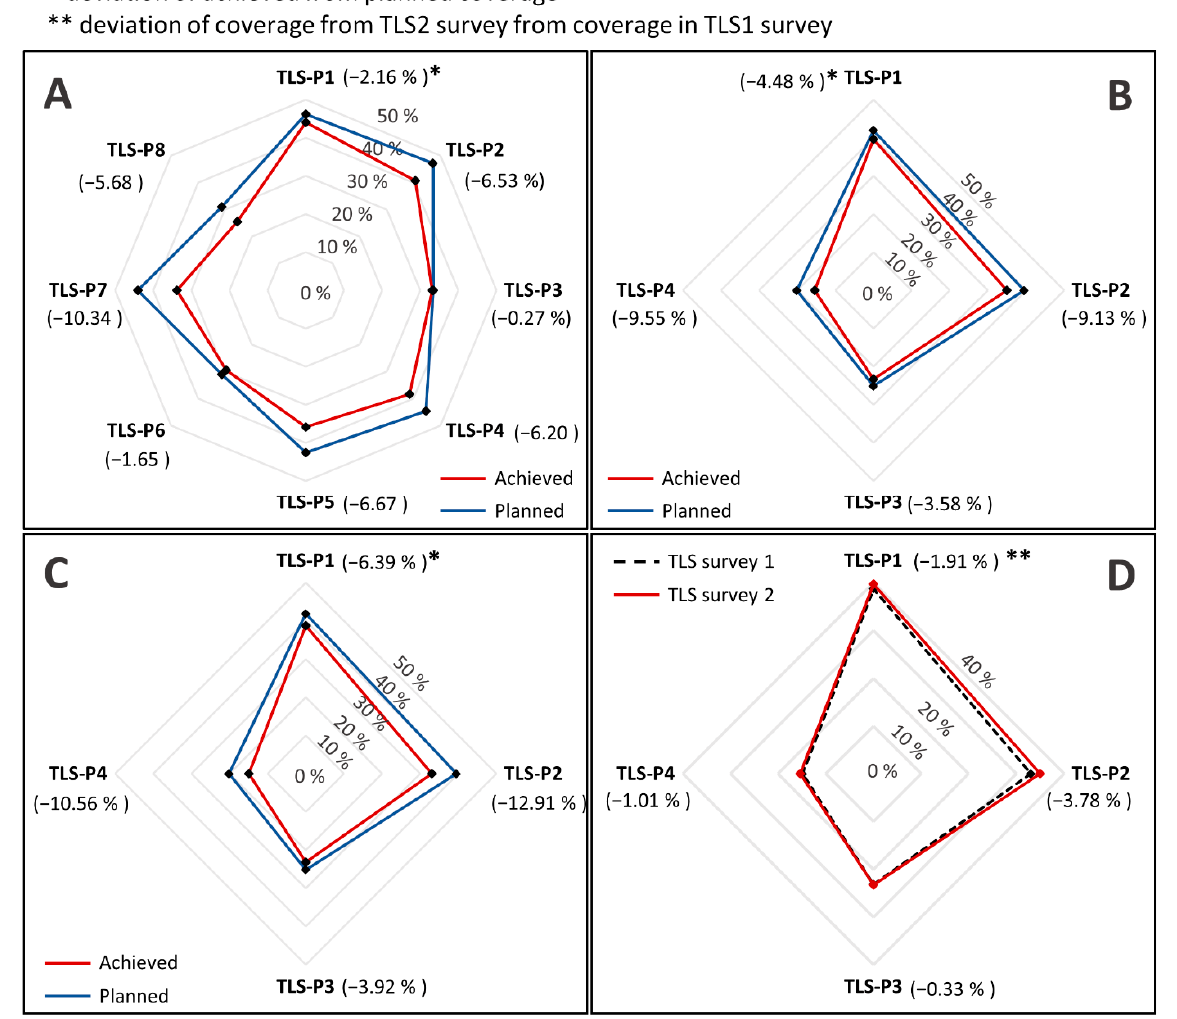
Figure 10. Deviation of planned and achieved coverage for every individual TLS position (( A )—Deviation of initial TLS survey of whole gully Santiš (SA-1); ( B )—Deviation of initial TLS survey of gully headcut (SA-2); ( C )—Deviation of second TLS survey of gully headcut (SA-2)) and difference in achieved coverage of gully headcut (SA-2) between TLS survey 2019 and TLS survey 2020 ( D ).